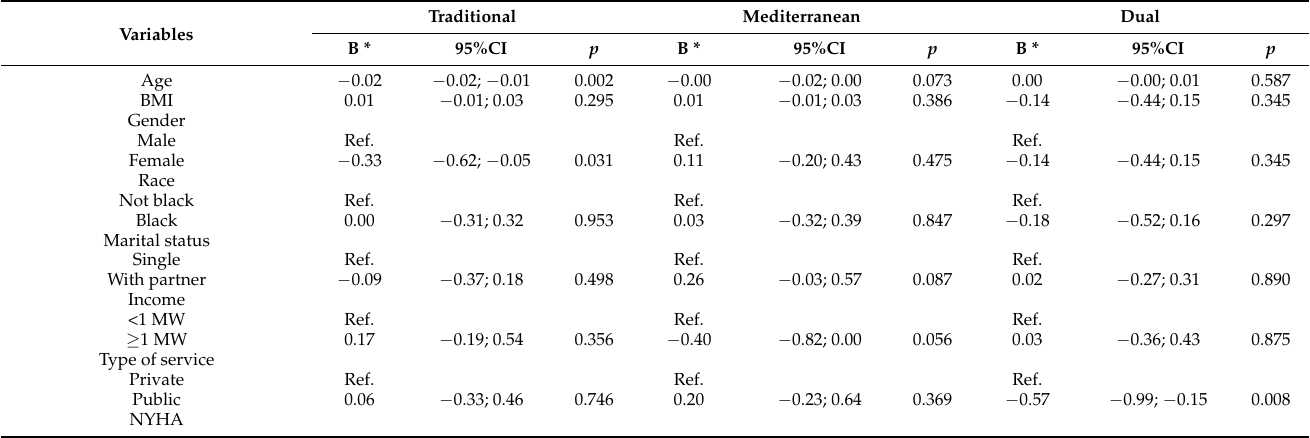
Table 5. Demographic, economic and clinical factors and the type of care associated with dietary patterns of patients hospitalized with CHF in Aracaju, SE,